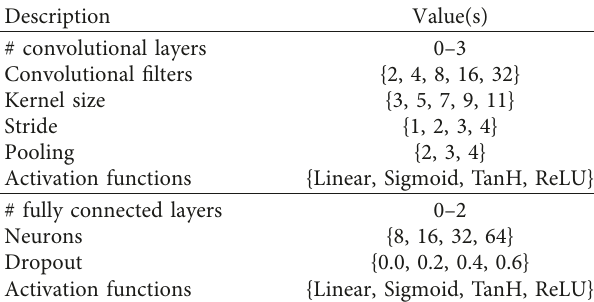
Figure 1: Layer descriptor examples. In (a), a convolutional layer, activated by ReLU, with 8 filters, a 7 7 kernel, stride of 4, and pooling × of 3. In (b), a fully connected layer, activated by TanH, with 32 neurons and a dropout rate of 0.6. Table 1: Search space